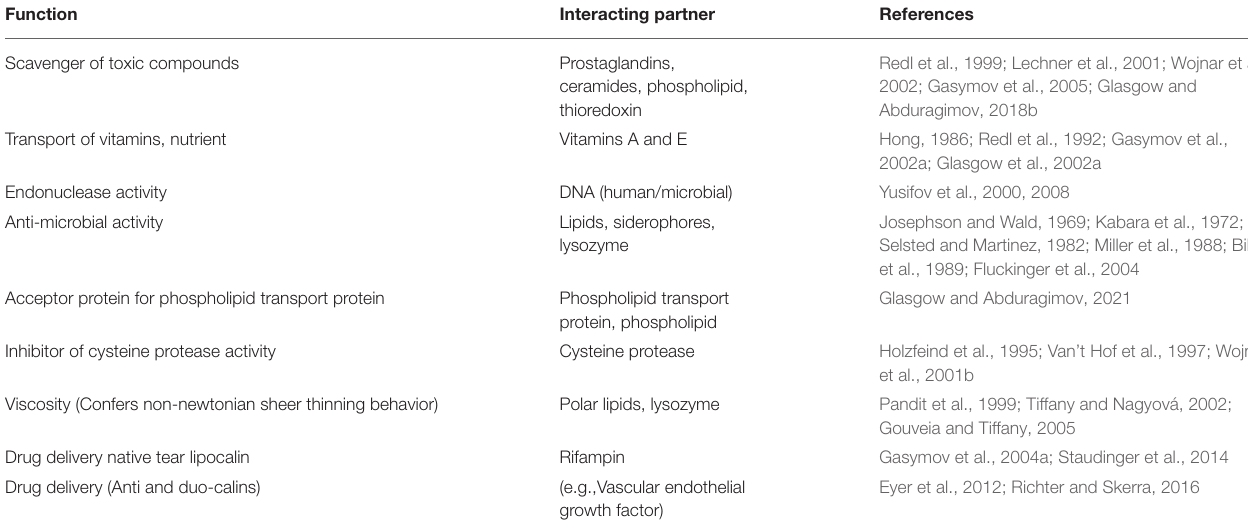
TABLE 2 | Functions of tear